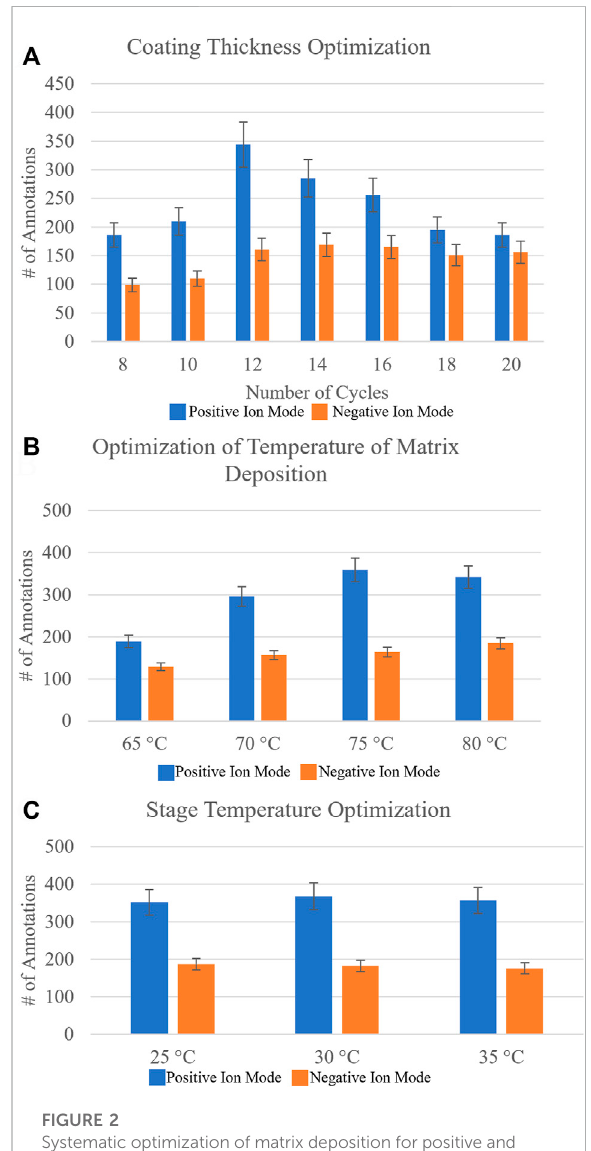
FIGURE 2 Systematic optimization of matrix deposition for positive